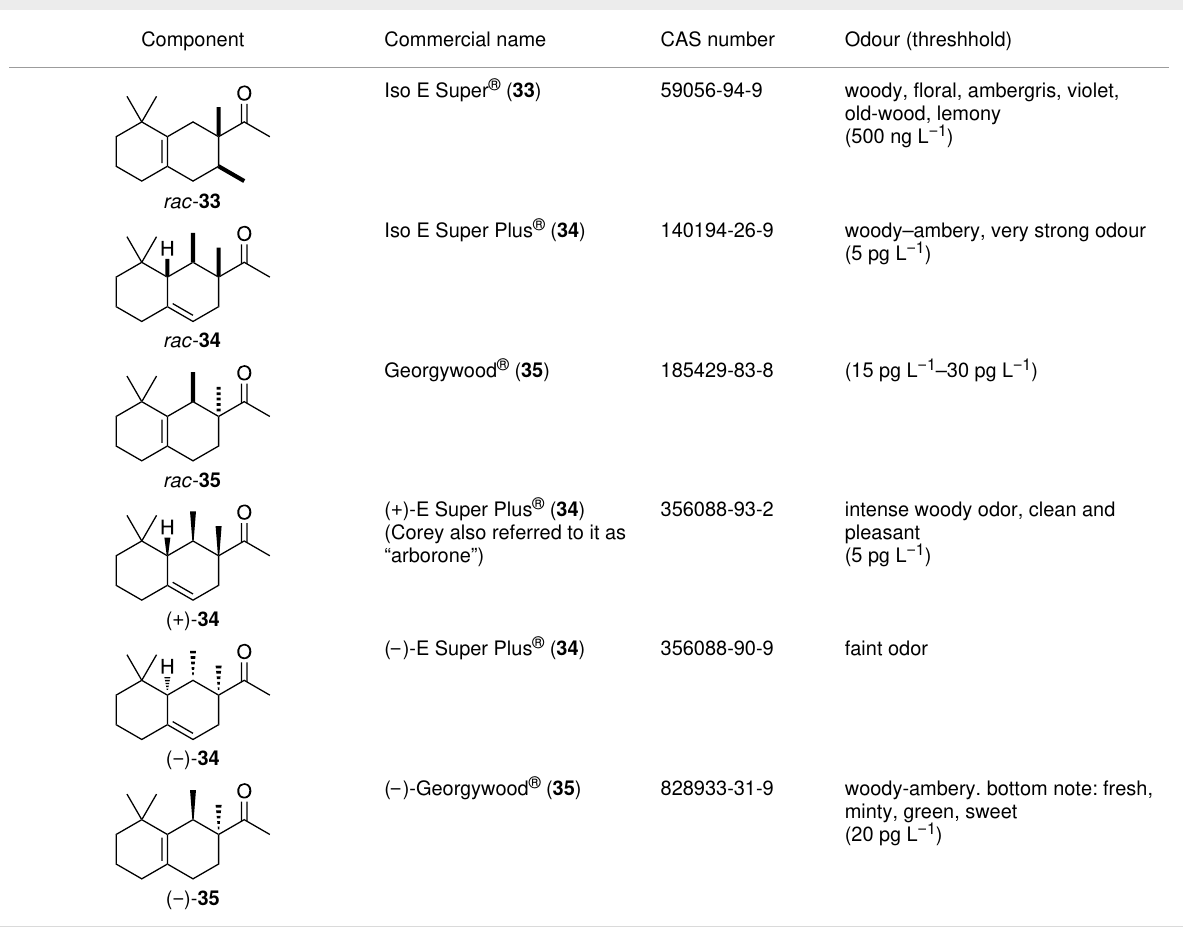
Table 1: Individual components of the complex Iso E Super ®